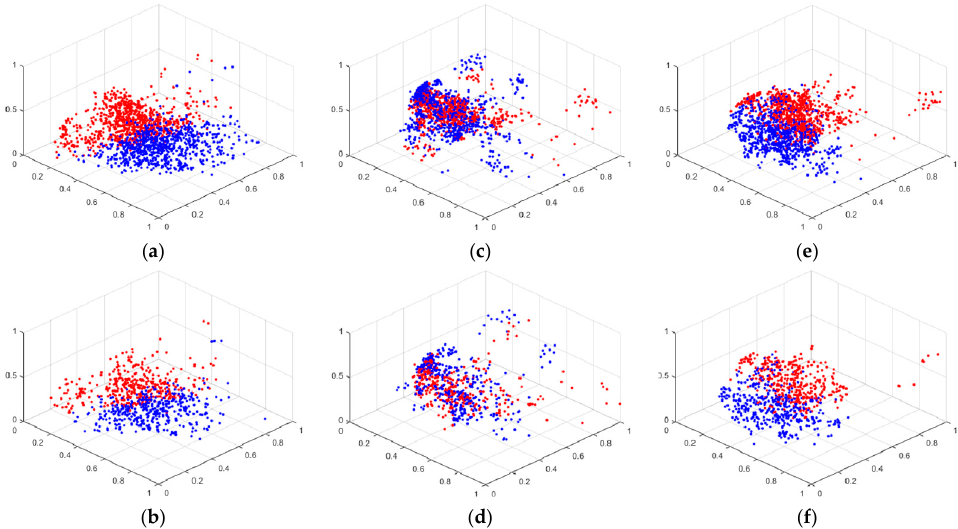
Figure 9. The feature visualization of the experiment with face and eye model: ( a ) training with face model, ( b ) testing with face model, ( c ) training with eye model, ( d ) testing with eye model, ( e ) training with fusion model, and ( f ) testing with fusion model.